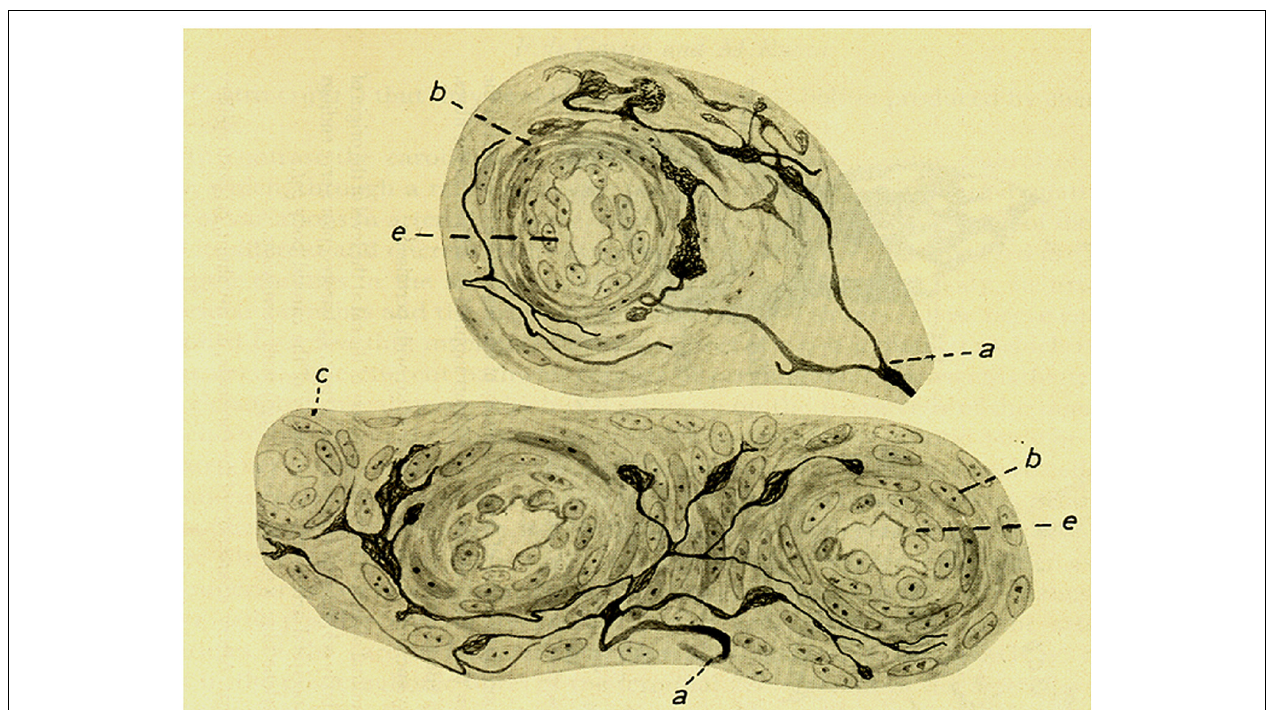
hammer-like endings. Note that in the lower figure the fiber and its terminals are located in the angle formed by the branching of one artery. The preparation was stained by the Cajal’s reduced silver nitrate method (in de Castro, 1926; courtesy of Fernando-Guillermo de Castro from the Archive Fernando de